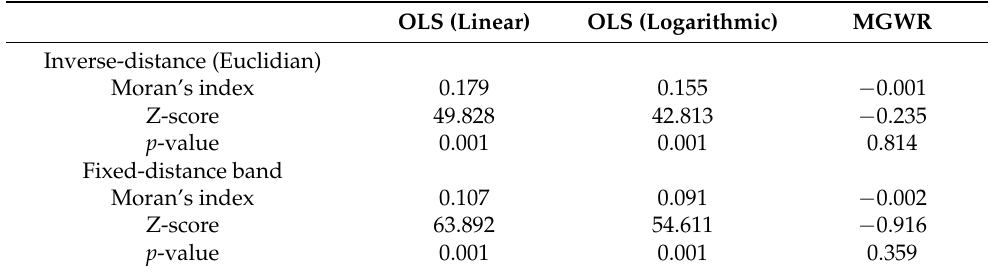
Table 4. Results from spatial autocorrelation statistic for the models explaining agricultural land conversion.